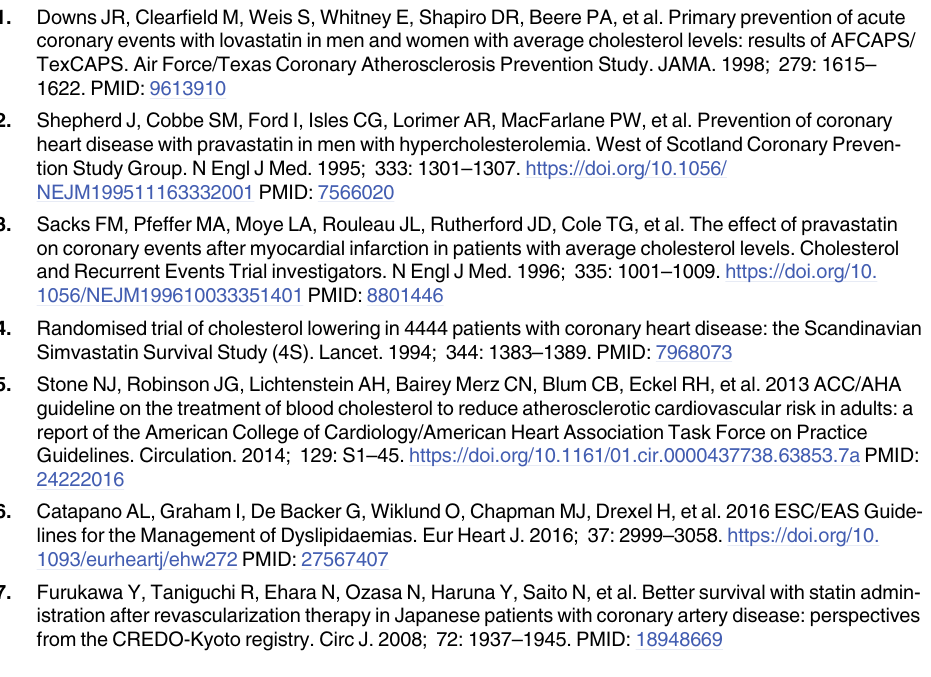
S2 Table. Clinical outcomes according to statin therapy. S3 Table. Frequency and doses of statins in moderate- and high-intensity statin therapy groups. S4 Table. Characteristics of patients according to statin